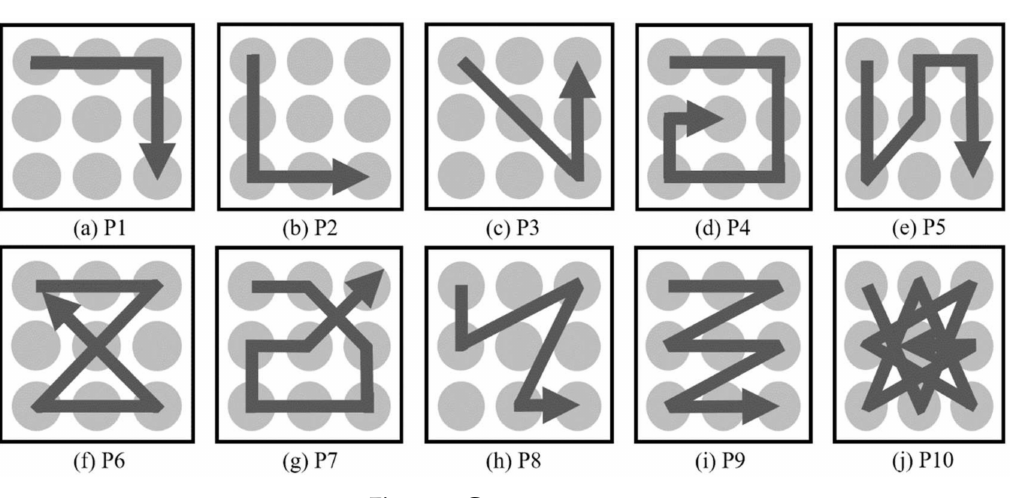
Figure 3. Gesture